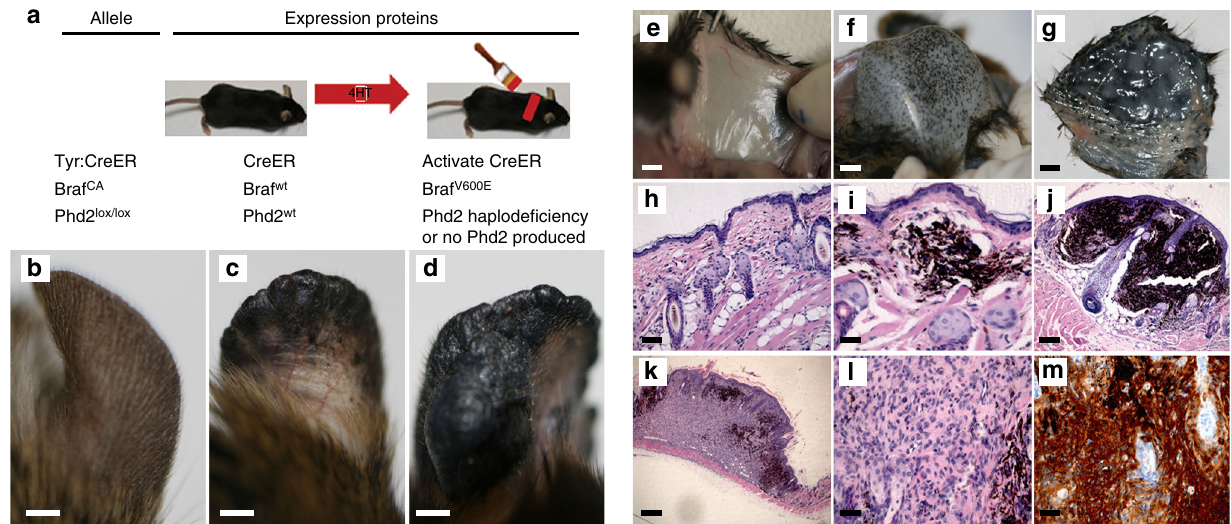
Fig. 2 Phd2 loss cooperates with BRaf V600E to induce malignant melanoma in mice. a Treatment scheme. Mice carrying various conditional alleles of BRaf ( BRaf CA ) and/or Phd2 ( Phd2 lox/lox ) were crossed to the Tyr::CreER mice with melanocyte-speci fi c expression of a hormone-dependent form of Cre recombinase ( CreERT2 ). 4-OHT-dependent activation of the CreER recombinase leads to a melanocyte-speci fi c conversion of BRaf CA → BRaf V600E and the conversion of the Phd2 lox alleles to Phd2 − / − alleles. b – g Melanoma progression in mice. Tyr::CreER;BRaf CA ; Phd2 lox/lox mice were treated topically with 4-OHT on the ear ( b – d ) and fl ank ( e – g ). 4-OHT-treated mice were killed at 40, 80 and 120 days after the induction. The pigmented lesions at fl ank and ear was photographed at days 40 ( b , e ), 80 ( c , f ), and 120 ( d , g ) following the 4-OHT induction. h – m Histology of melanoma in mice. Mouse tissues were processed and histology was examined using hematoxylin and eosin stain. Increased pigmented cells in the dermis were present at day 40 ( h ) and pigmented cells formed small tumor nodules in the dermis at day 80 ( i ). At day 120, melanoma cells formed bigger tumor nodules ( j , k ). Cytologically, these tumor cells were focally pigmented and had enlarged nuclei, a morphology that is similar to human melanoma ( l ). Tumor cells were stained positive for the S100 antibody ( m ). Bars in b – g indicate 5 mm. Bars in h – j indicate 200 μ m. Bar in k indicates 400 μ m. Bars in l , m indicate 50 μ